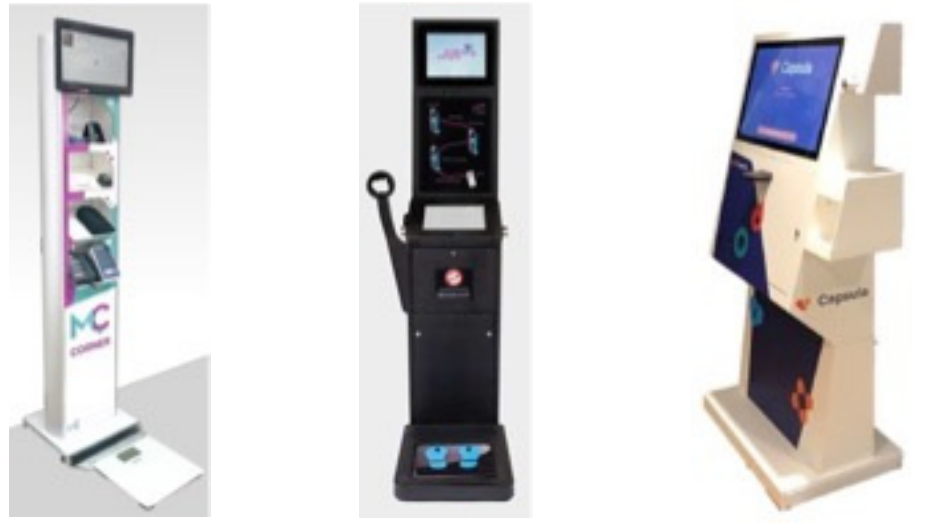
Figure 2. Example of totem solutions.